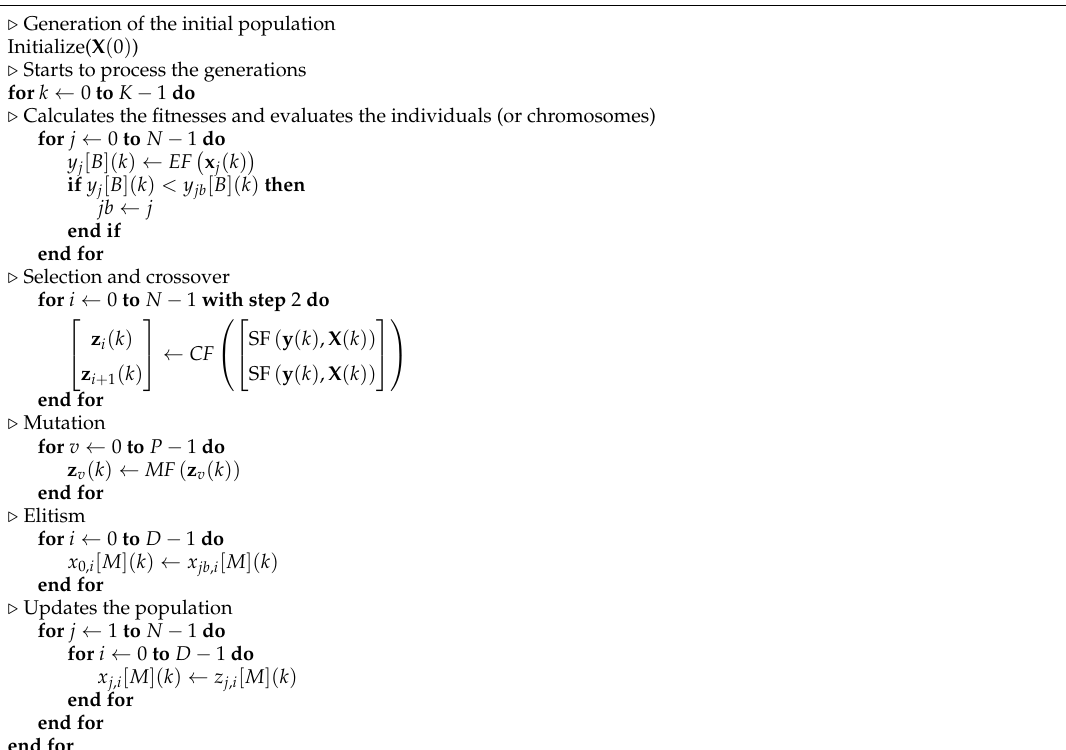
Algorithm 1 Genetic Algorithm